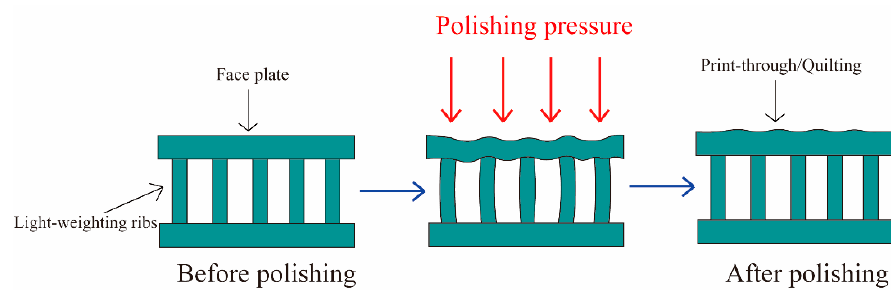
Figure 37. An illustration of the surface distortions created during the polishing process [64].